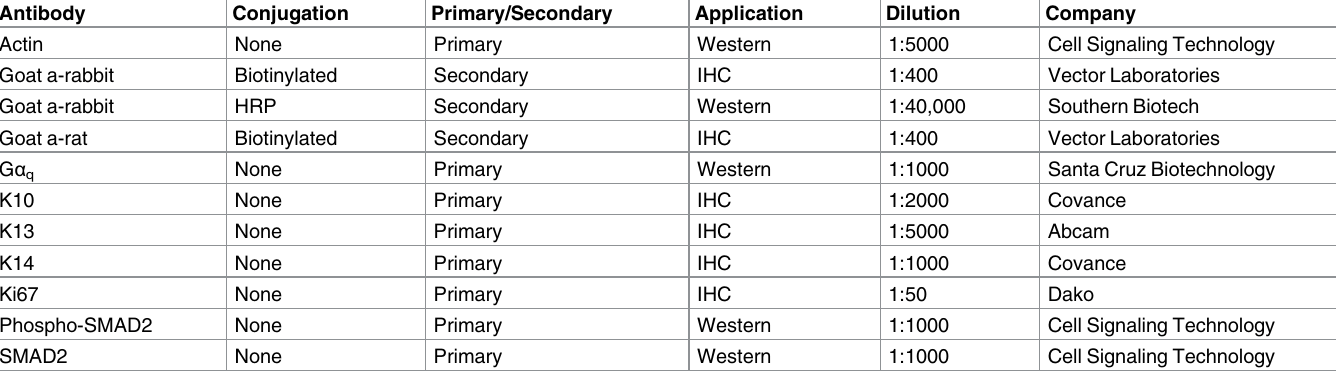
Table 1. Antibodies and experimental conditions. This table details the antibodies,their formulation, experimental application, dilution,and source for all experiments in this manuscript.